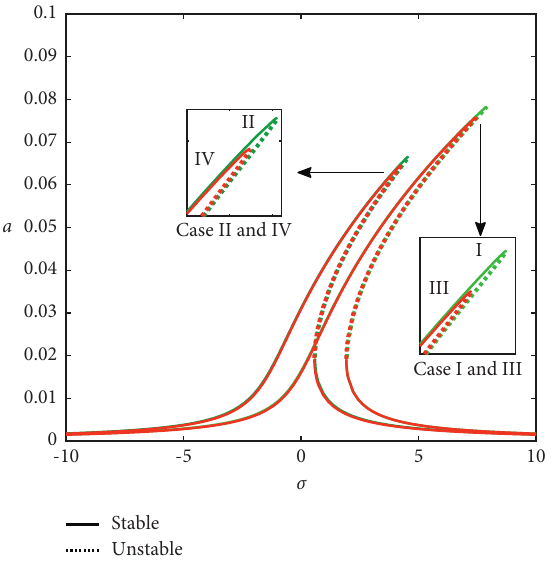
Figure 39: The frequency response curve for the four cases (L/d � 10, c � 0.01, θ � 0 ° , Ω � 100).